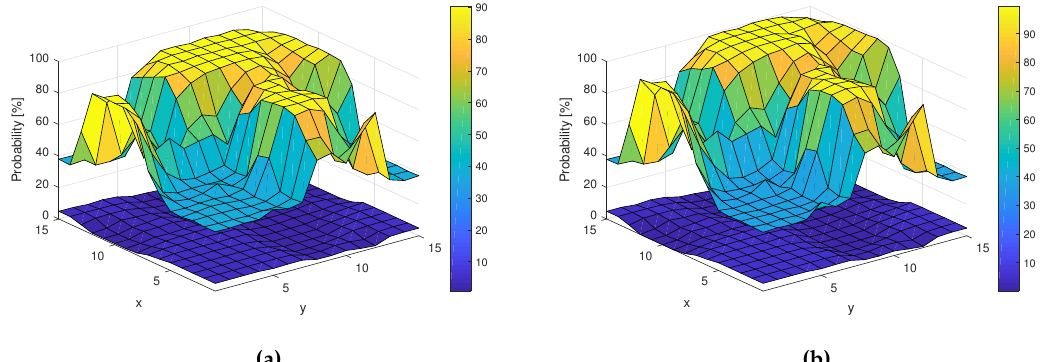
Figure 15. P d and P fa for the k-Nearest Neighbors method applied in different locations. ( a ) P d and P fa surfaces for Energy Detection-based k-Nearest Neighbors; ( b ) P d and P fa surfaces for Energy Vector-based k-Nearest Neighbors.